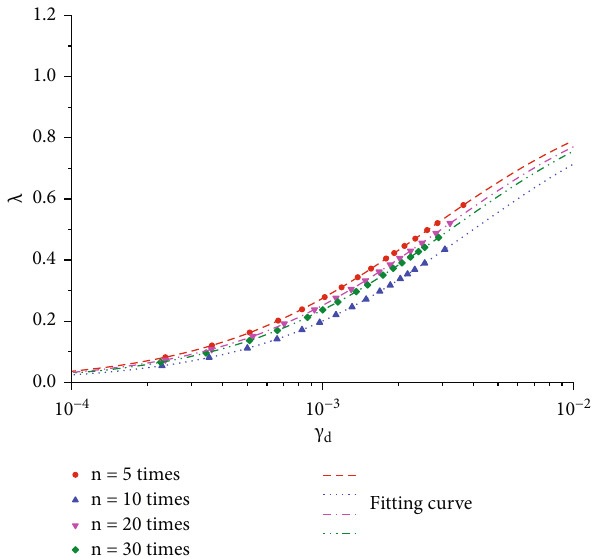
Figure 17: Damping ratio-strain curves under di ff erent freeze-thaw cycles (-10 ° C).